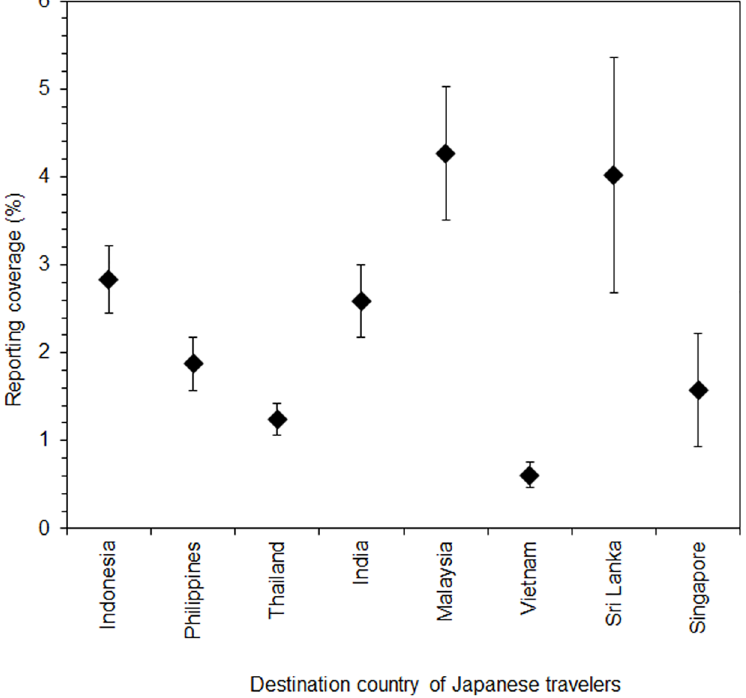
Fig 3. Estimated reporting coverage of dengue virus infection among travelers by destination country. Filled diamonds represent maximum likelihood estimates; whiskers extend to lower and upper 95% confidence intervals. Travelers were assumed to have experienced an identical force of infection of dengue virus infection to the local